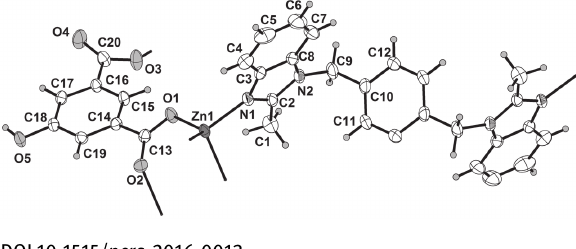
Table 1: Data collection and